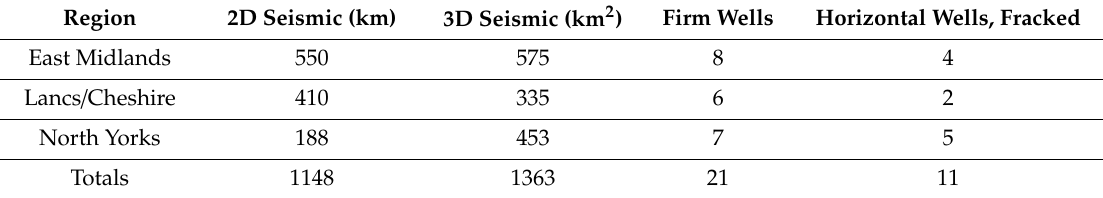
Table 1. INEOS work commitments to be completed within 5 years from 21 July 2016. Region 2D Seismic (km) 3D Seismic (km 2 ) Firm Wells Horizontal Wells, Fracked East Midlands 550 575 8 4 Lancs / Cheshire 410 335 North